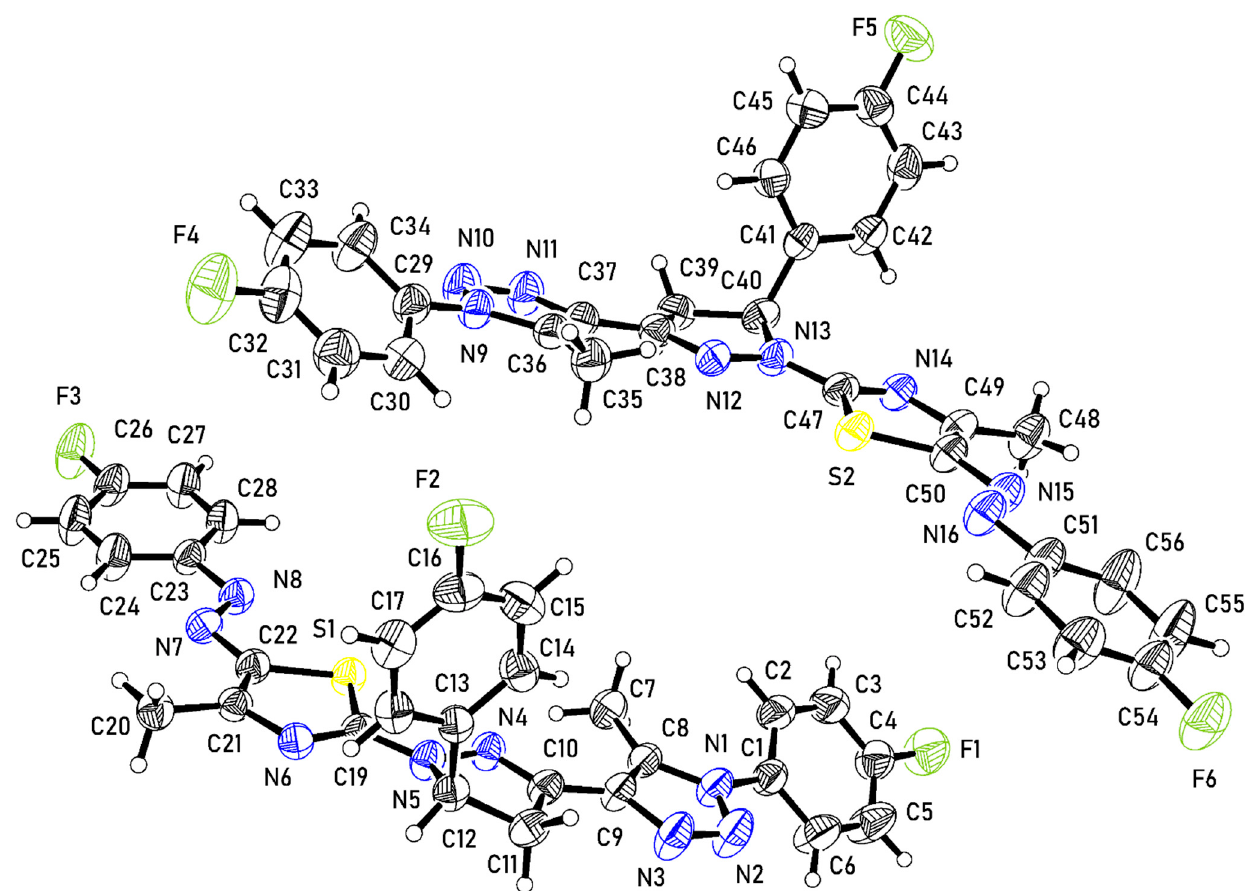
Figure 4. An ortep representation of 9 showing 50% probability atomic displacement ellipsoids.